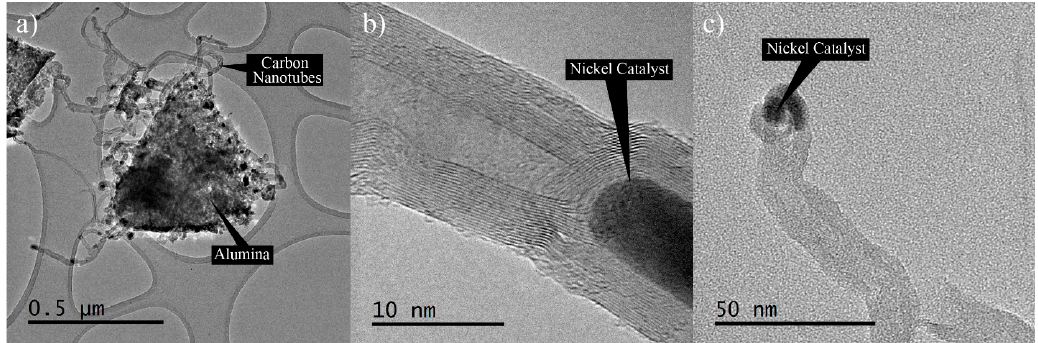
Figure 3. High-resolution transmission electron microscopy (HRTEM) images of HYB.